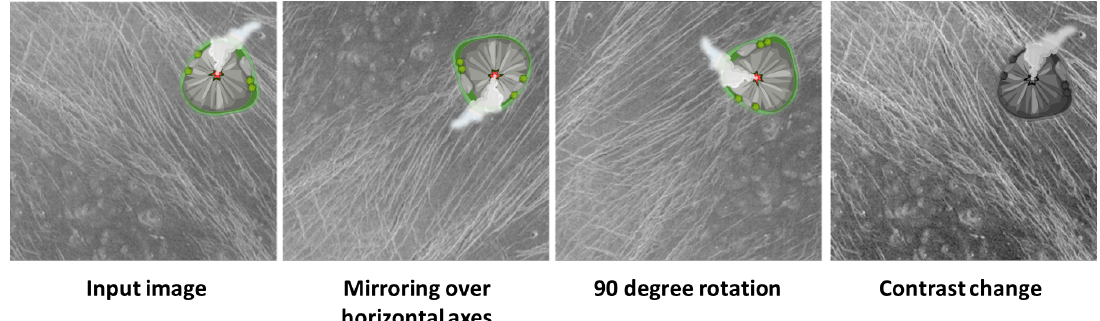
Figure 9. Examples of standard dataset augmentation